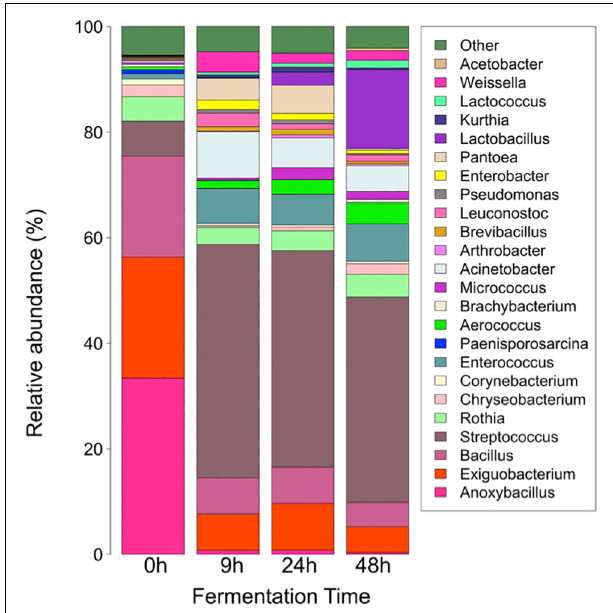
FIGURE 1 | Change in the structure of pozol bacterial communities over fermentation time. Taxonomic assignation was made by metabarcoding (V3-V4, 16S r DNA). “Other” includes all genera with relative abundance lower than